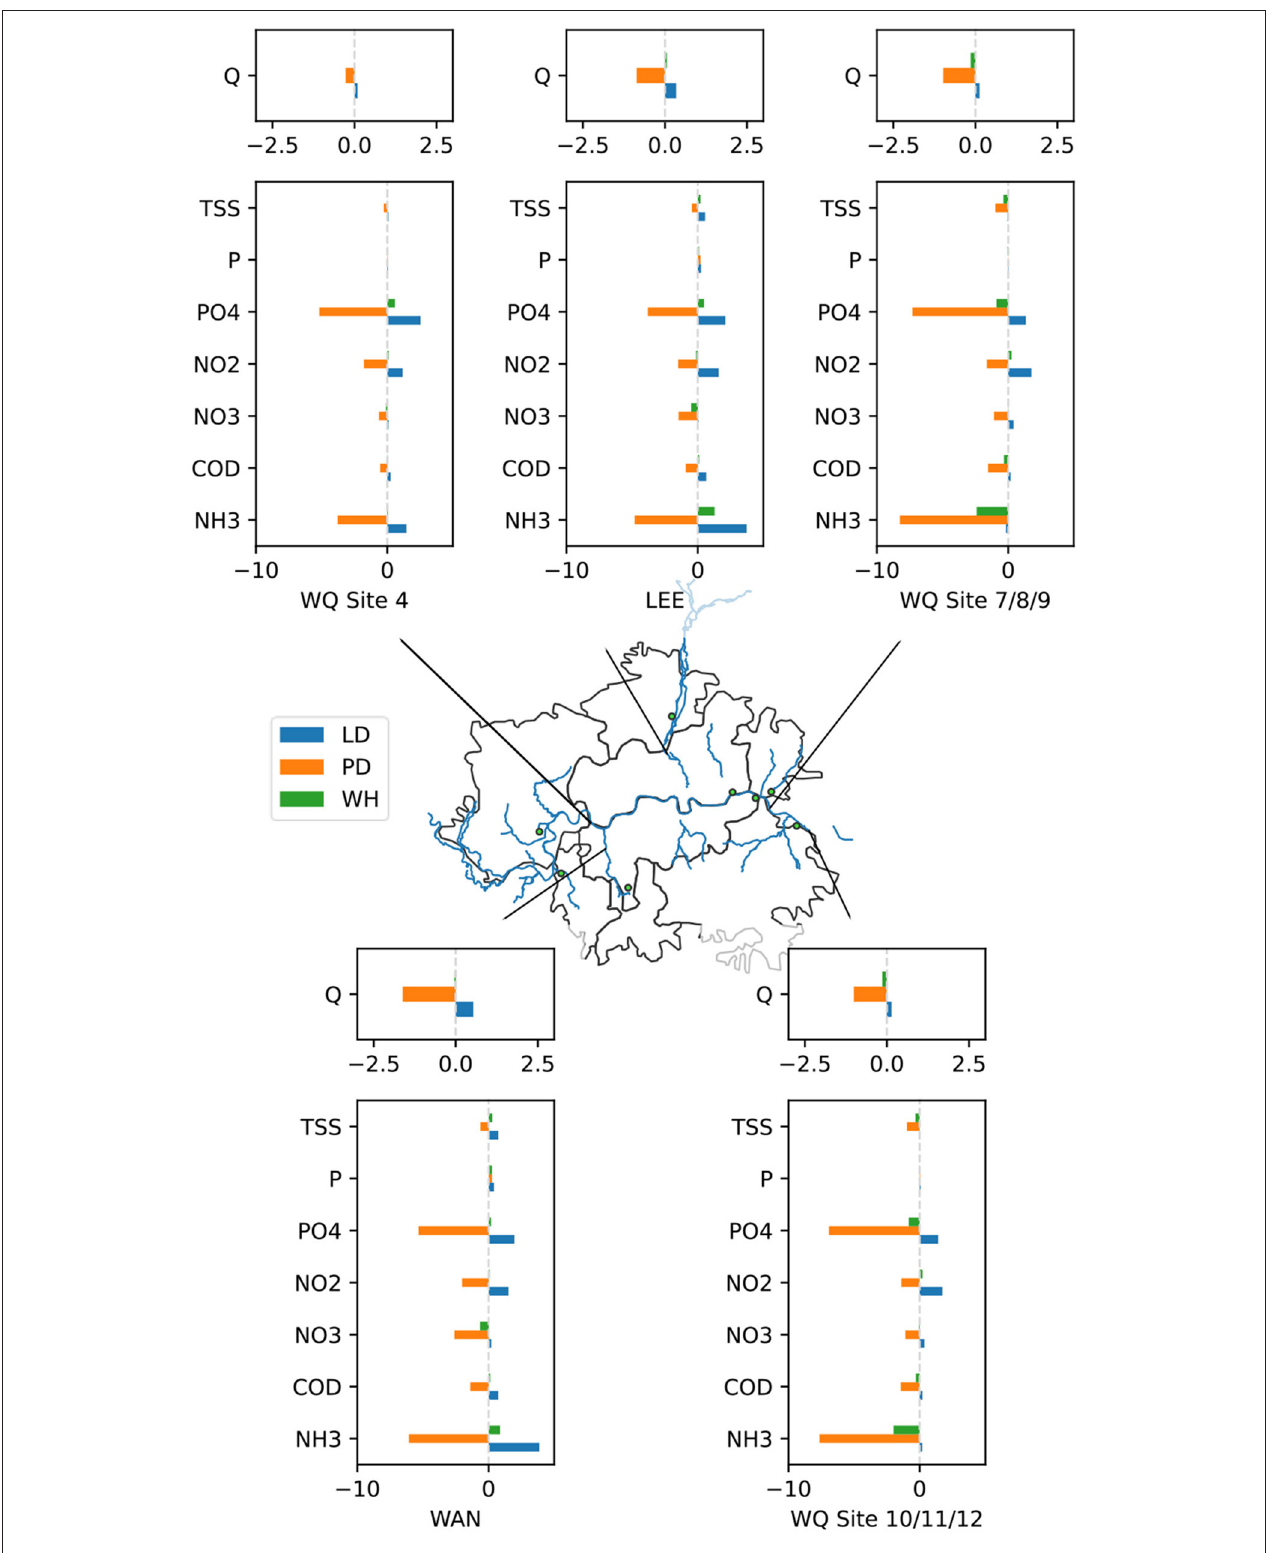
FIGURE 11 | Map depicting percentage changes in river flow and pollutant concentration (these are the bars). LD stands for the lockdown scenario, PD stands for the population decrease scenario and WH stands for the work from home scenario.